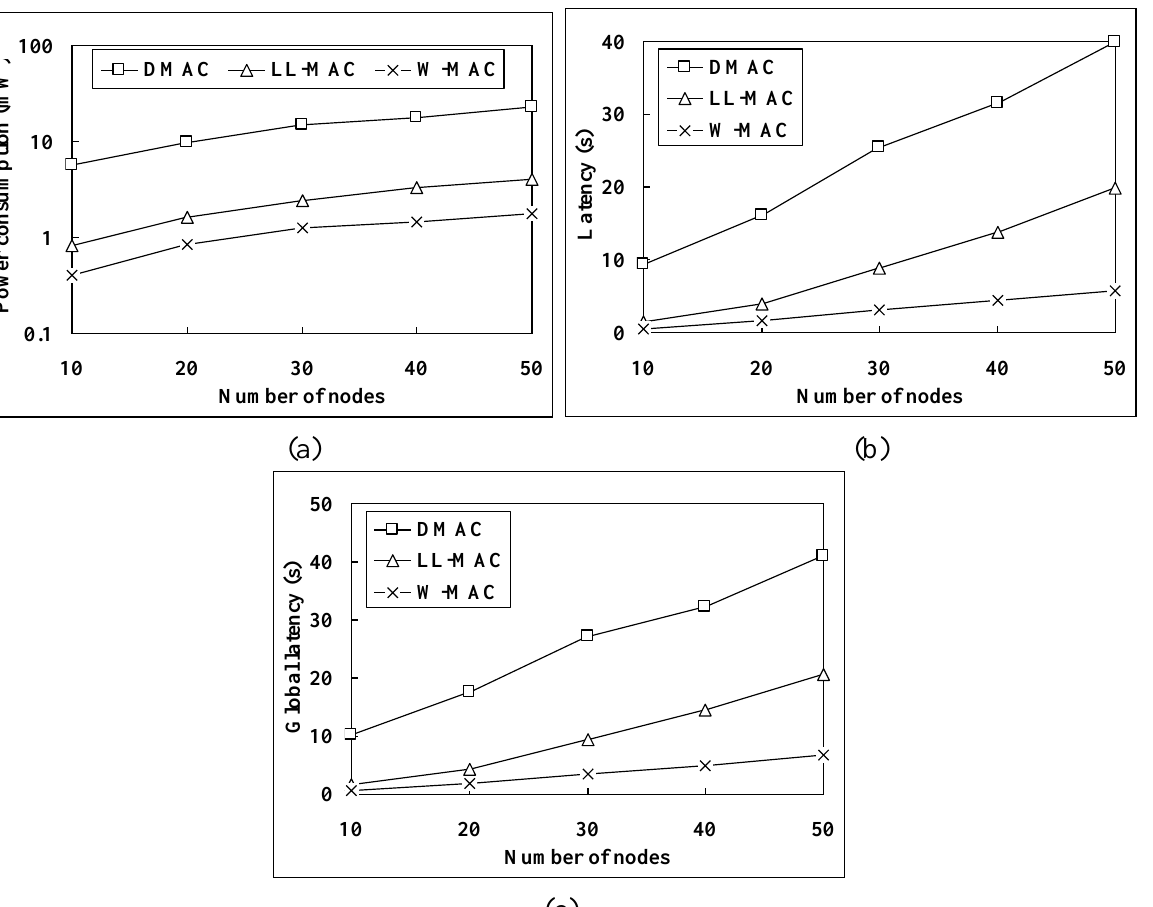
Figure 8. Protocols comparison: (a) power consumption; (b) latency and (c) global